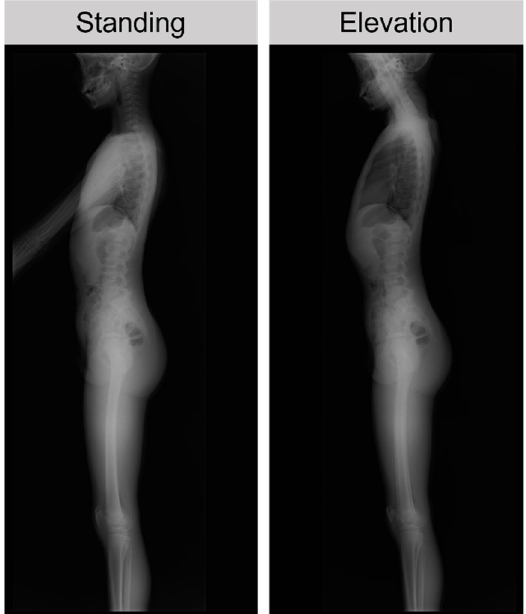
Figure 1. Patient position for X-ray evaluation. The patient was instructed to elevate both upper limbs to the maximum during elevation.